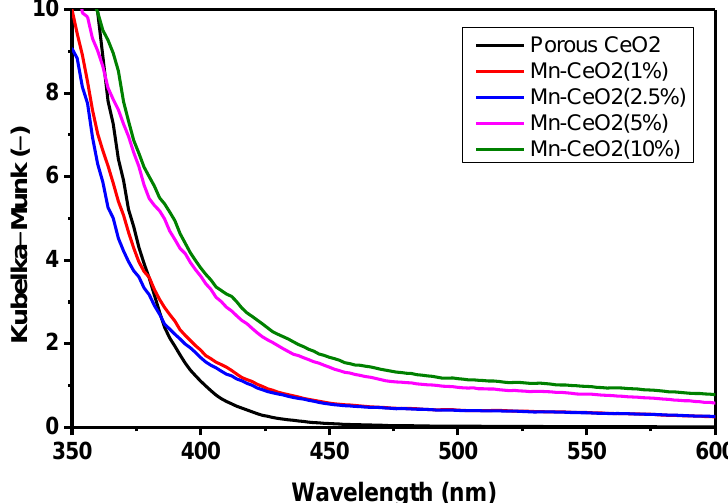
Figure 2. DR-UV-Vis spectra of the prepared neat and the Mn-doped porous ceria.